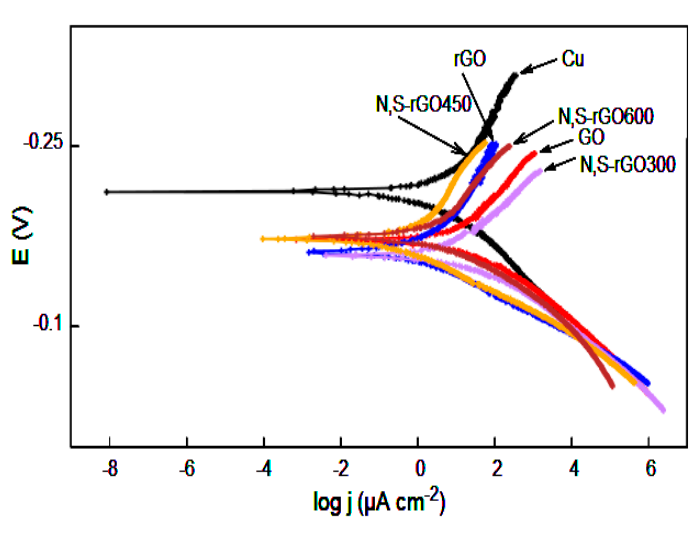
Figure 9. Polarization curves for copper and graphene coatings.